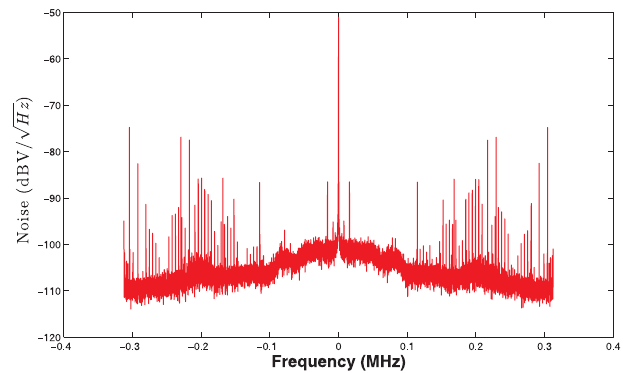
FIG. 5. (Color) Noise power spectral density at the output of the LHC rf feedback for channel Q (wideband).